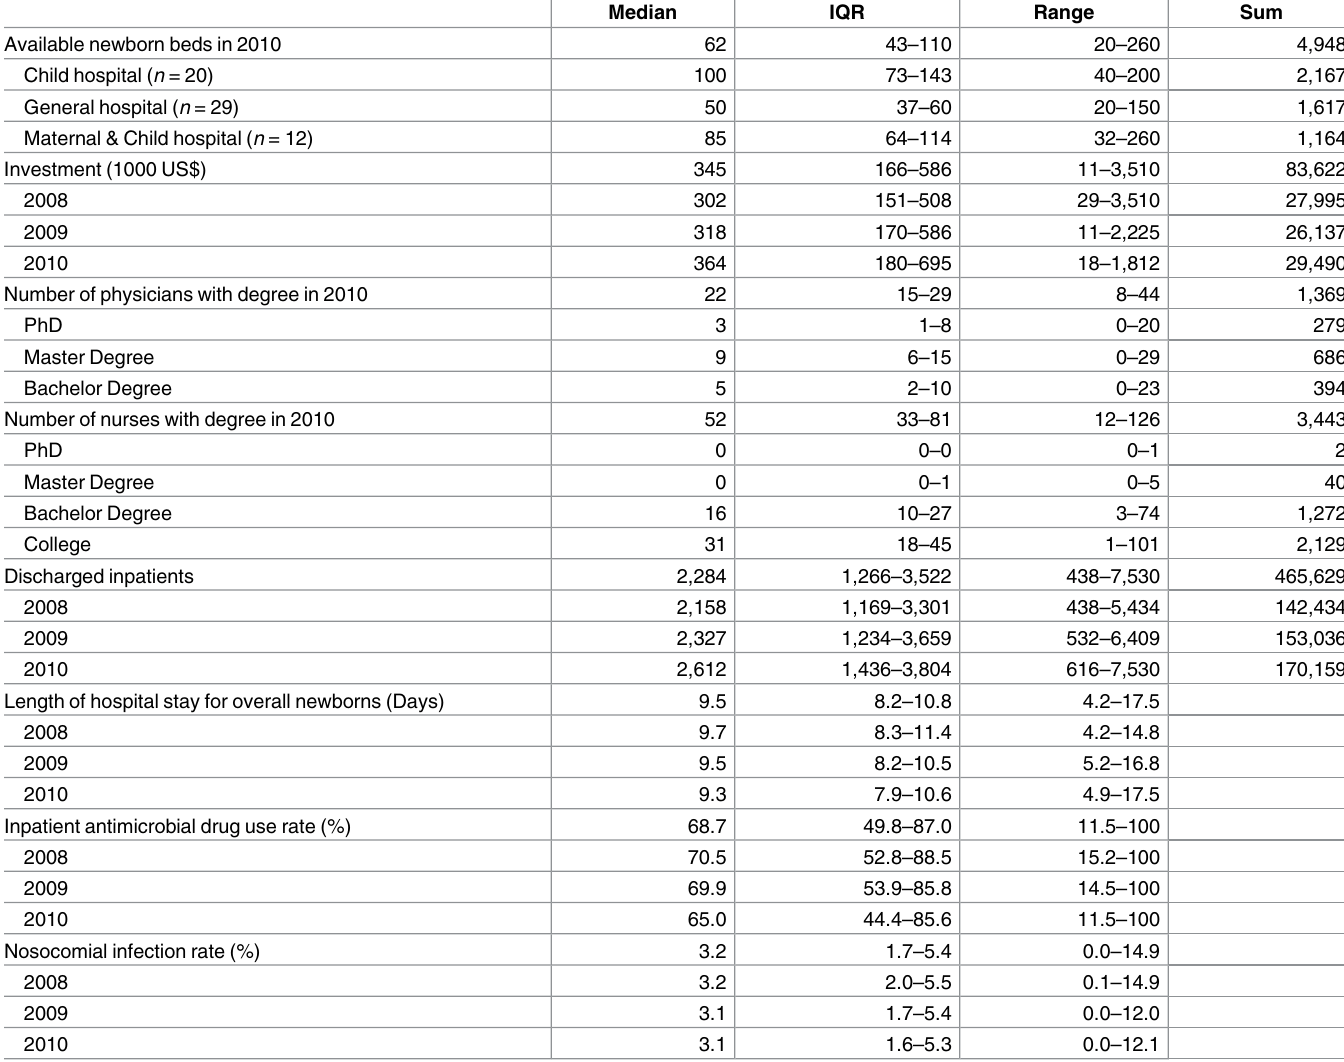
Table 1. Newborn unit investment, workforces and health care activities in 61 hospitals during